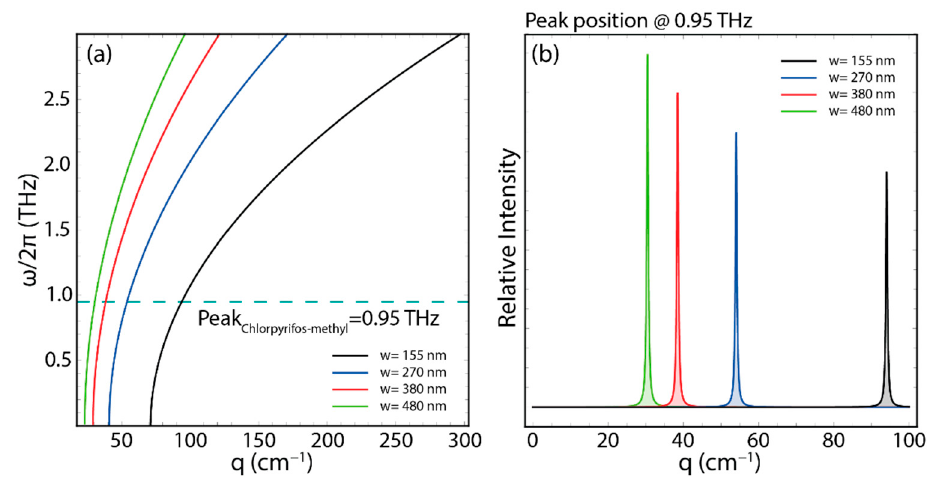
Figure 18. ( a ) Plasmon frequency dispersion ( ≤ 3 THz) ( ω /2 π ) vs. wave vector, considering different ribbons widths (155, 270, 380, and 480 nm). The parameters of Equation (4) have been fixed as: N 2 D = 2.5 × 10 12 cm − 2 , θ = 0, and ν = 2.24 s − 1 . ( b ) Plasmon excitation lifetime at ≈ 0.95 THz for momentum q ≤ 100 cm − 1 , considering different ribbons widths (155, 270, 380, and 480 nm). The plasmon spectra were calculated using the Lorentzian shape function to a maximum value of 1 with FWHM = 0.5 .